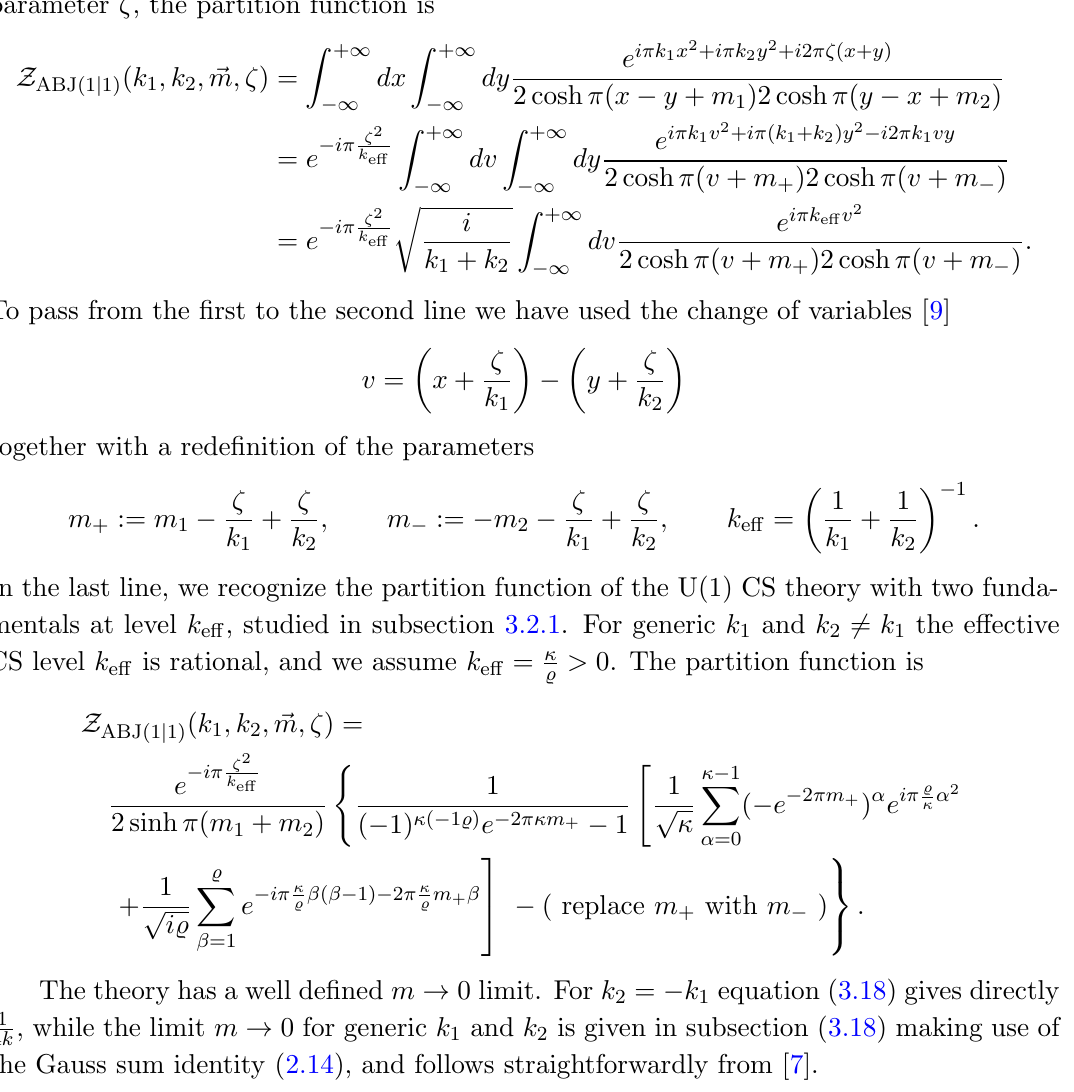
Figure 12 . The simplest non-Abelian A 2